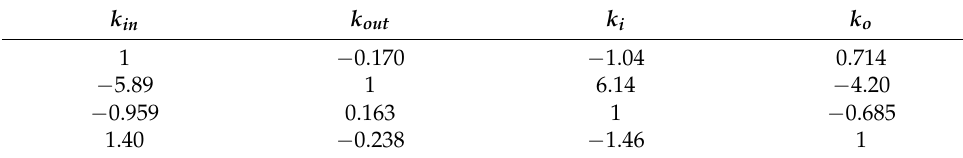
Table 8. OGs possible combinations with ICE working at 1400 rpm and 1045 Nm.